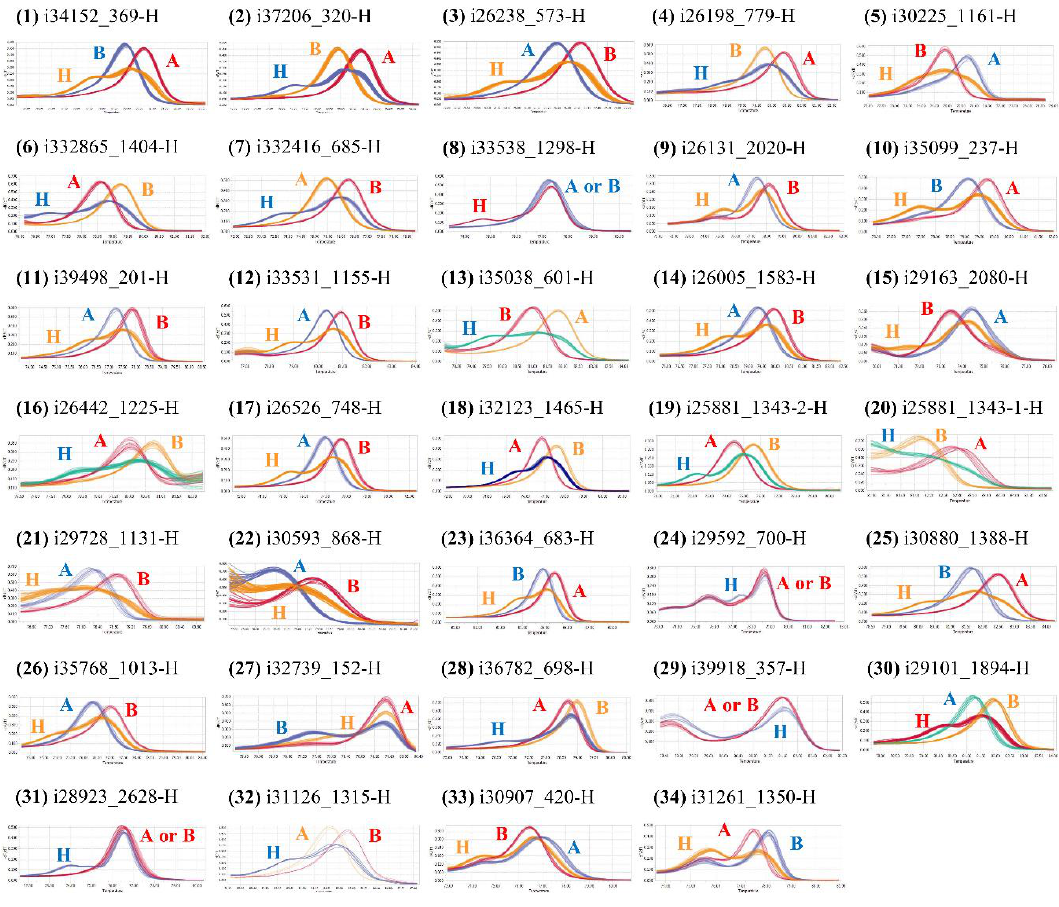
Figure 1. Melting curves of 34 high-resolution melting (HRM) markers developed in this study. A, marker type of female parent (SP3B); B, marker type of male parent (H6); H, marker type of